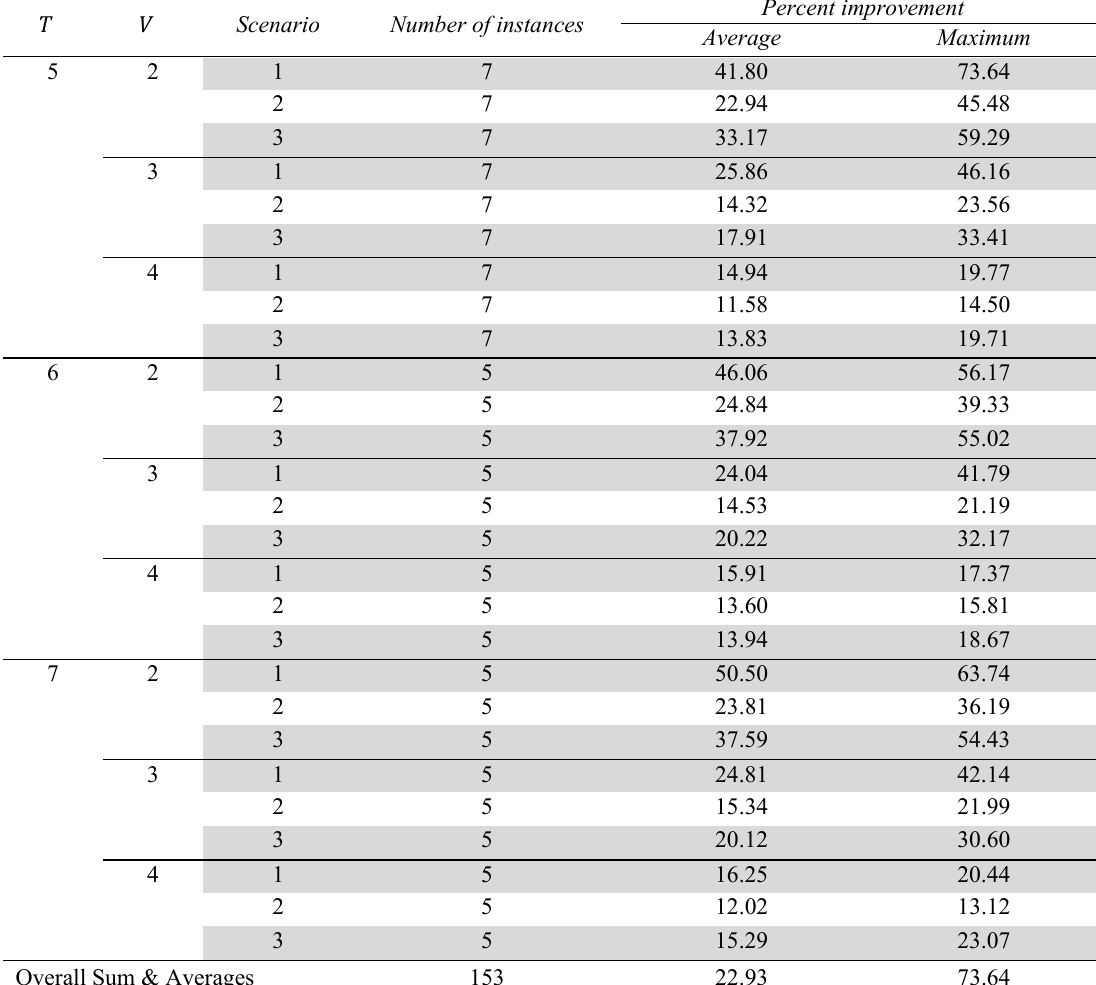
Improvements in total costs brought by the MILP-D model over the MILP-C model 𝑇 𝑉 Scenario Number of